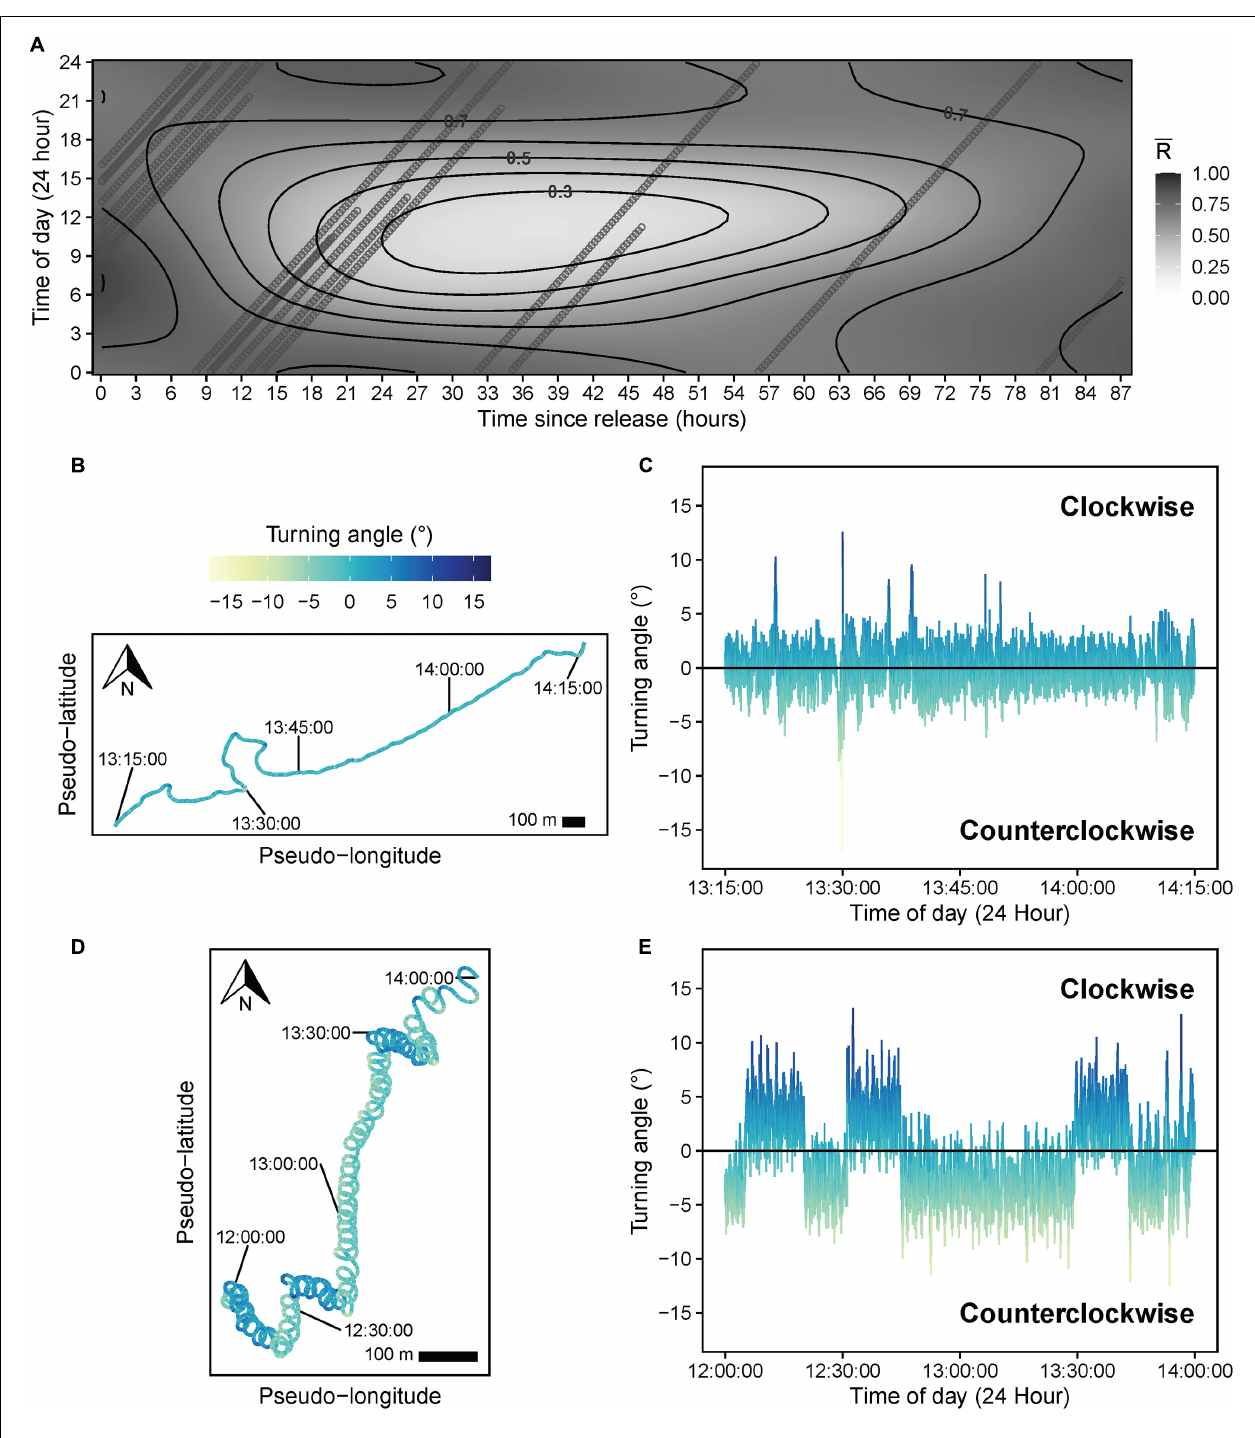
FIGURE 8 | (A) Response surface showing predicted values for mean resultant length ( R ) based on a significant tensor smooth interaction of time of day (TOD) and time since release (TSR) from a beta generalized additive mixed model. Heading variance (path tortuosity) decreases as R increases from 0 (tortuous swimming) to 1 (linear swimming). Points show the distribution of predictor values (TOD and TSR) for all individual sharks across the response surface. (B) One hour pseudo-track and (C) corresponding turning angle data (computed at 1 s intervals), illustrating linear swimming during the middle of the day shortly ( ∼ 1 h) after release. (D) Two hour pseudo-track and (E) corresponding turning angle data illustrating highly tortuous, clockwise, and counterclockwise circular swimming behavior during the middle of the day, ∼ 24 h after release. The turning angle color legend is consistent across all turning angle and pseudo-track plots. X - and Y -axes are scaled equally for pseudo-tracks. A 100 m scale bar is provided to indicate the approximate relative scale of movement, assuming a fixed swimming speed (0.82 m s − 1 ) for each